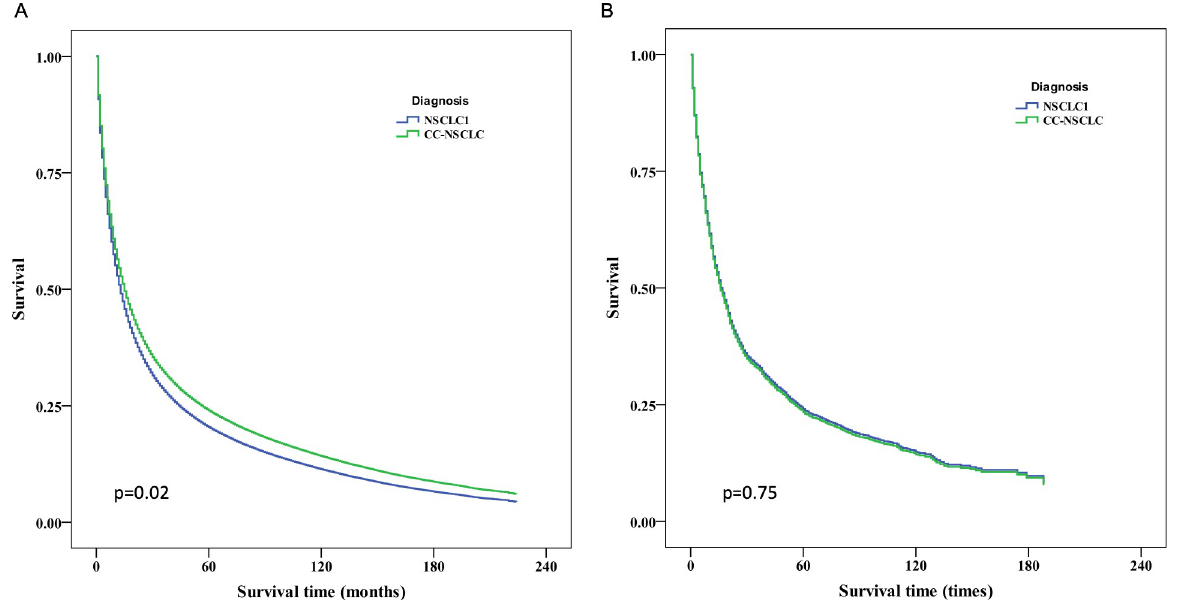
Fig 1. mOS for CC-NSCLC and NSCLC1 before and after PSM. (A) Kaplan–Meier survival curves indicated that patients with CC-NSCLC had significantly longer survival compared with patients with NSCLC1 before PSM (16 months vs 13 months; P < 0.05). (B) Kaplan–Meier survival curves indicated that patients with CC-NSCLC had no significant extension in survival relative to patients with NSCLC1 after PSM (16 months vs 15 months; P > 0.05).